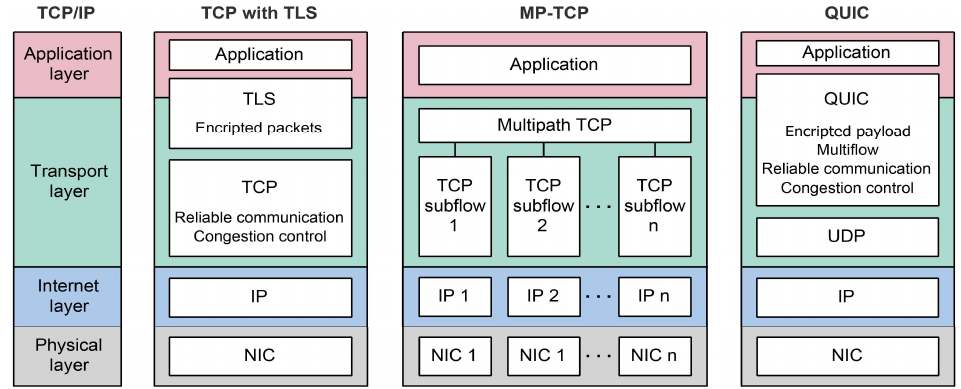
Figure 6. Comparison between TCP with TLS, QUIC and MP-TCP protocol stacks.